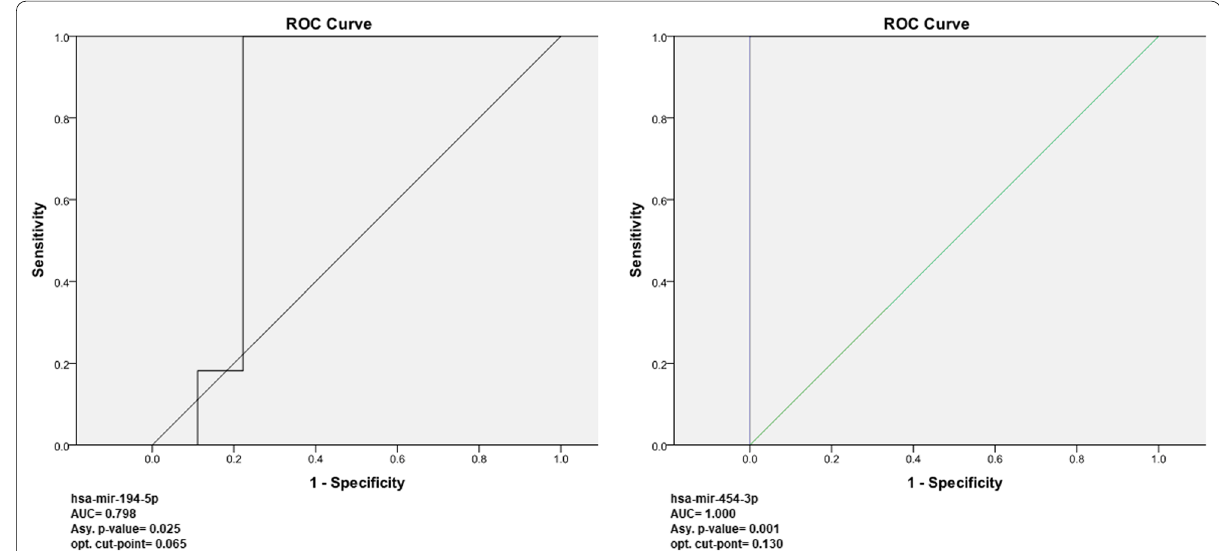
Fig. 2 Receiver operating characteristic (ROC) curve of circulating mir‑194‑5p and 454‑3p for the diagnosis DCM